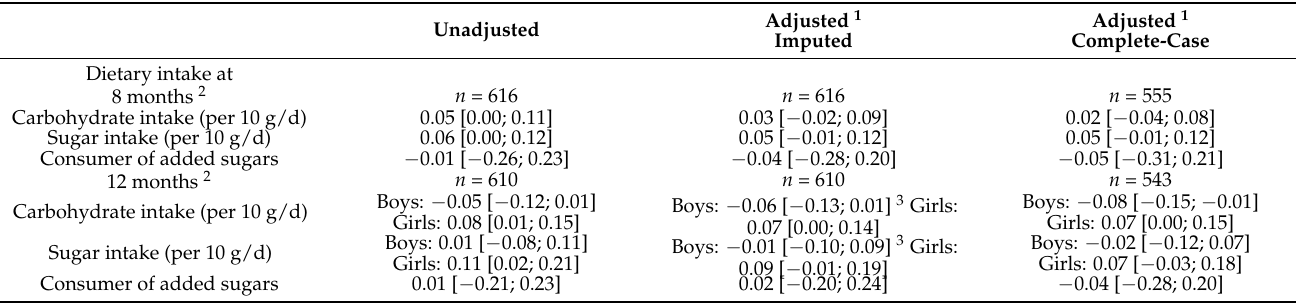
Table 3. Associations ( β (CI 95%)) between infant dietary intakes and their liking for sweetness score in young children.